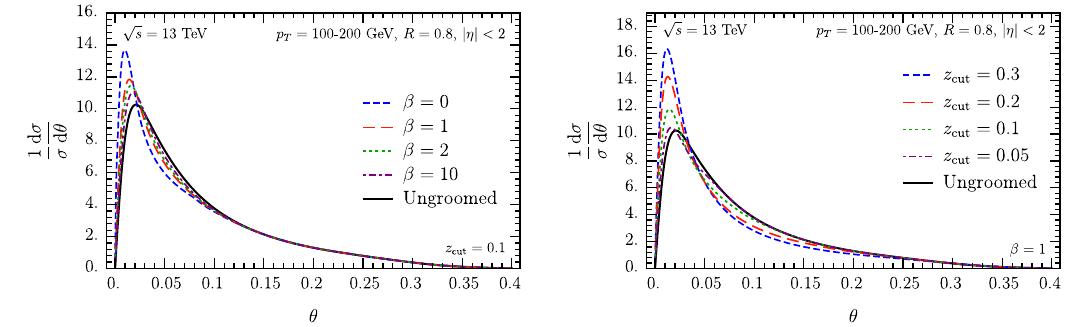
Figure 10 . Left: numerical results for the angle between the WTA and the soft drop groomed jet axis with z cut = 0 : 1 and di(cid:11)erent values of (cid:12) = 0 ; 1 ; 2 ; 10. Right: results for a (cid:12)xed value of (cid:12) = 1 but di(cid:11)erent values of z cut = 0 : 05 ; 0 : 1 ; 0 : 2 ; 0 : 3. In both panels we show the ungroomed result (solid black) for